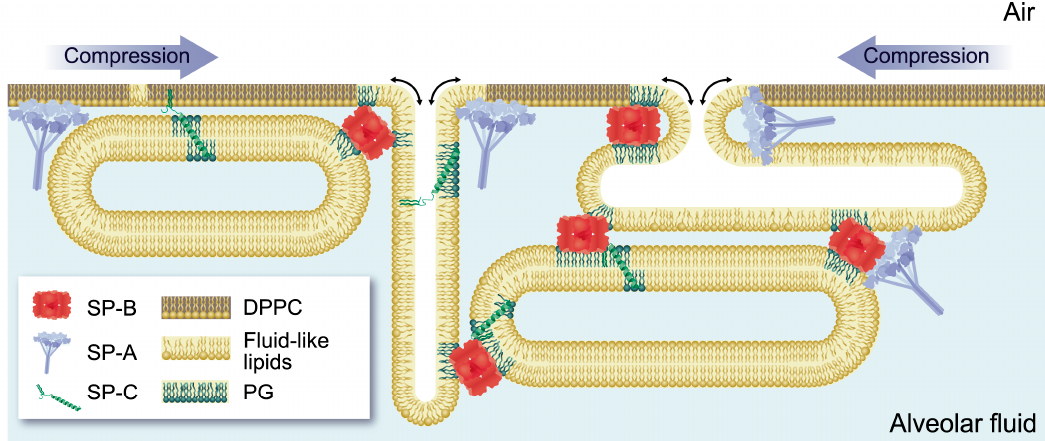
Figure 2. Lipid–protein interactions in the mechanical stabilization of alveoli during breathing cycles. Surfactant proteins SP-B and SP-C facilitate surfactant dynamics by regulating the mechanical properties of surfactant membranes and films through direct interaction with fluid-like lipids [36], including PG. Binding of SP-B and SP-C to unsaturated and anionic lipids would produce protein partitioning into fluid domains that may contribute to highly curved membranes [37], promoting lipid polymorphism [38–42] and favoring a compression-driven enrichment of the interfacial film in the most surface active component of surfactant, DPPC. On the other hand, by binding to DPPC at solid / fluid phase interfaces, SP-A promotes demixing of surfactant lipids, facilitating the segregation of unsaturated phospholipids at the interface [43] and, thus, modeling the mechanical properties of the surfactant film [44]. In addition, surfactant proteins A, B and C stabilize multilayered interfacial structures and preclude the out-of-plane relaxation of the surfactant film at the end of expiration by promoting membrane-membrane contacts: SP-A (oligomer shown, octadecamer) binds simultaneously to di ff erent membranes through its carbohydrate recognition domains [10]; SP-B forms rings (shown as hexamers of dimers) and tubes that connect di ff erent bilayers [45,46], and SP-C maintains insertion of palmitoylated cysteins at its N-terminal segment into highly packed liquid-ordered regions of the interfacial film [47,48]. Surfactant membranes may be further stabilized during the breathing cycles by SP-A / SP-B and SP-B / SP-C interactions. Notice that surfactant proteins in the cartoon are not represented at equivalent scale.